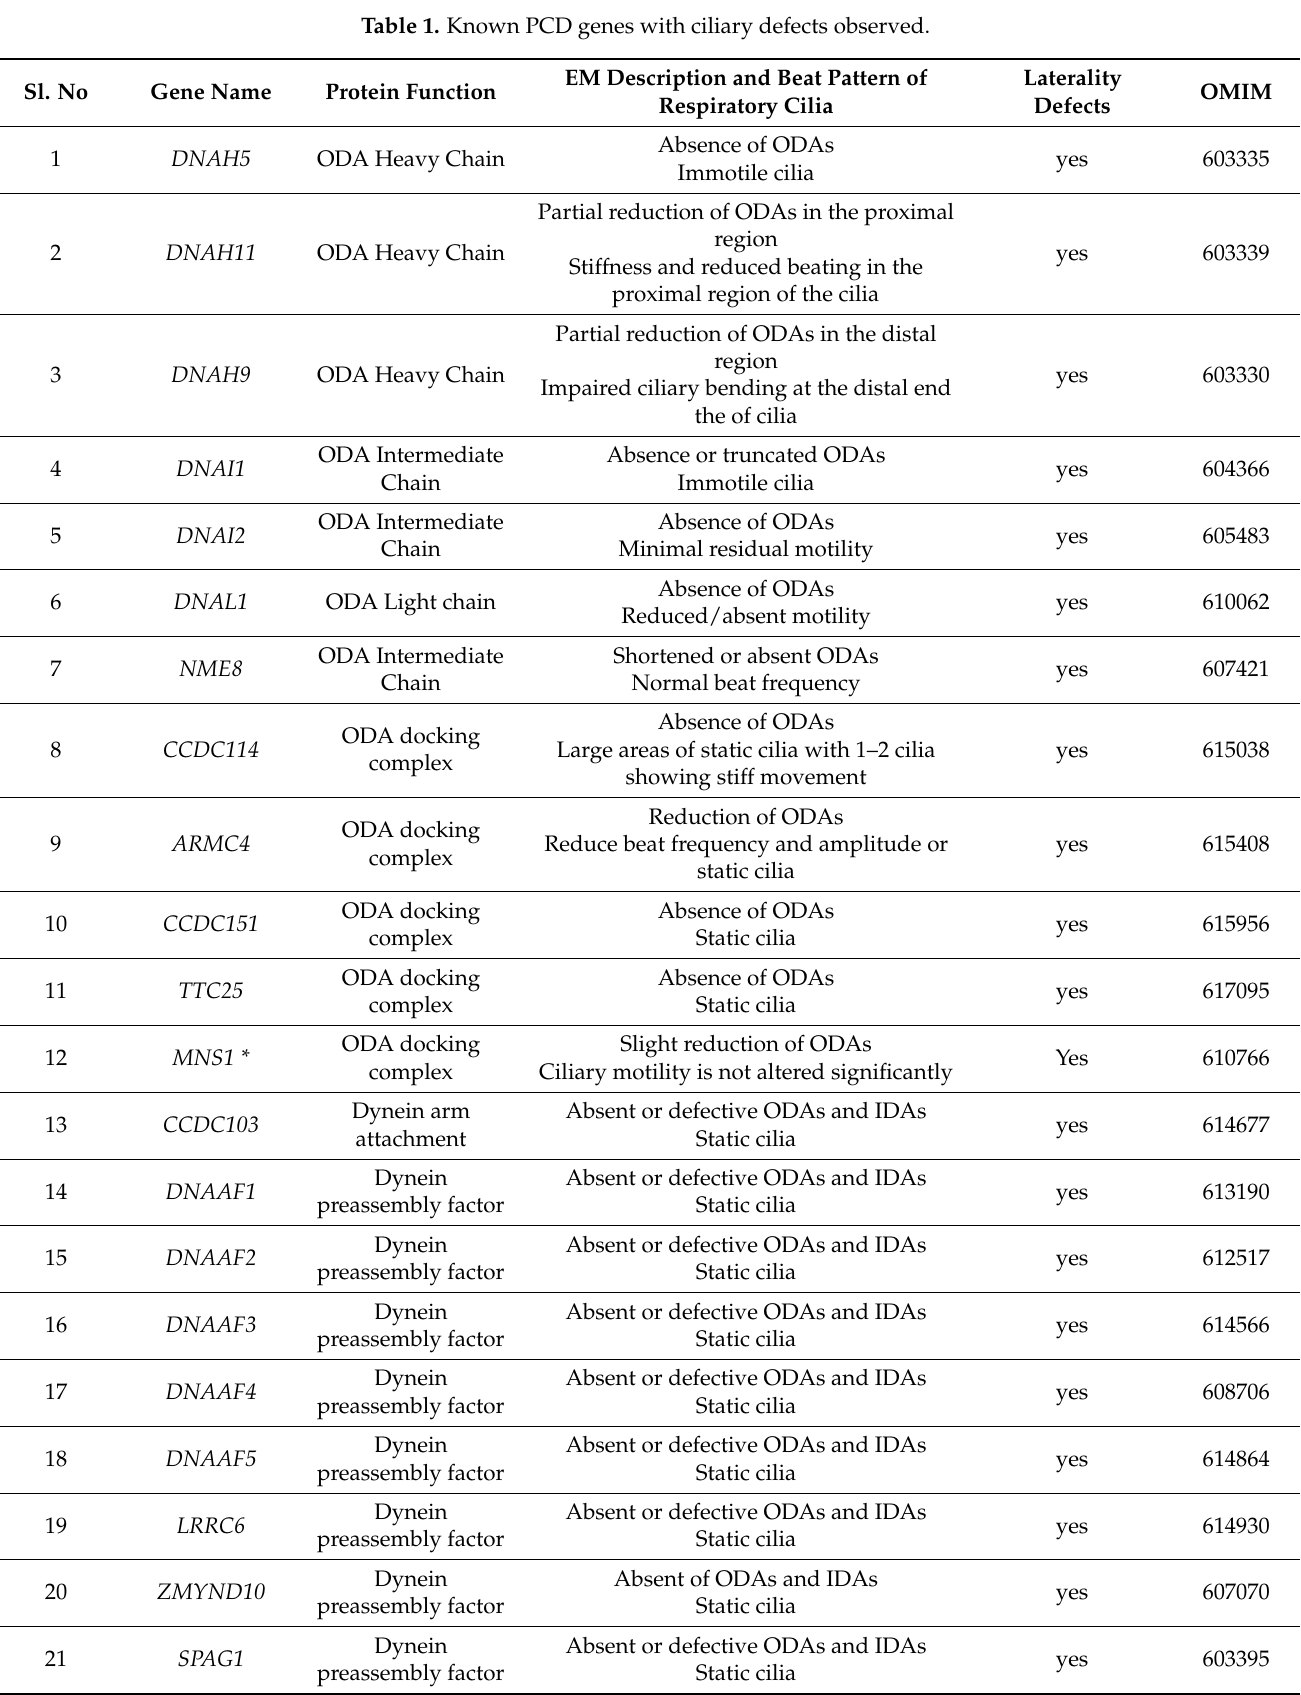
Table 1. Known PCD genes with ciliary defects